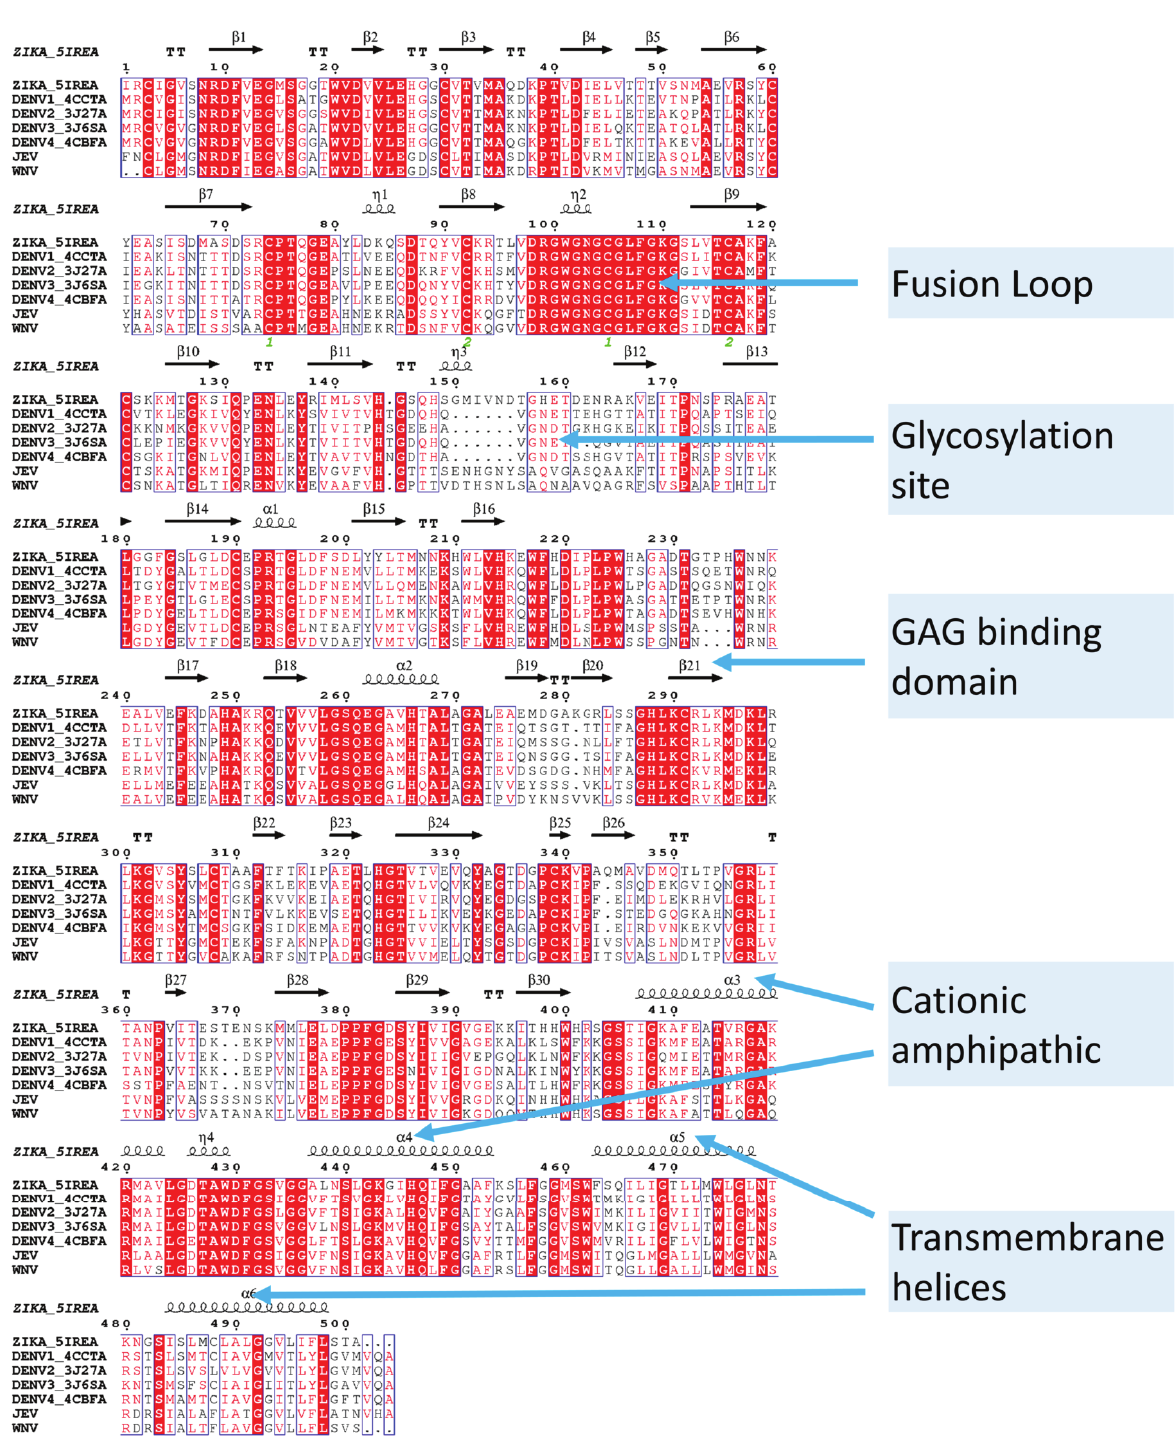
Figure 2. Multiple sequence alignment (MSA) of envelope (E) proteins from ZIKA/DENV1-4/JEV/WNV. The most prominent difference between the E protein from DENV and other viruses analyzed here is a missing stretch of amino acids near the Asn153 glycosylation site. This stretch is the possible reason for an incorrect alignment of the conserved glycosylation site (N-x-S/T) sequence in the MSA (both ClustalW and MAFFT has this issue). Also, DENV has an additional glycosylation site (Asn67) missing in other viruses. MSA was done using MAFFT 57 , and the alignment of the secondary structures were done using ESPript 58